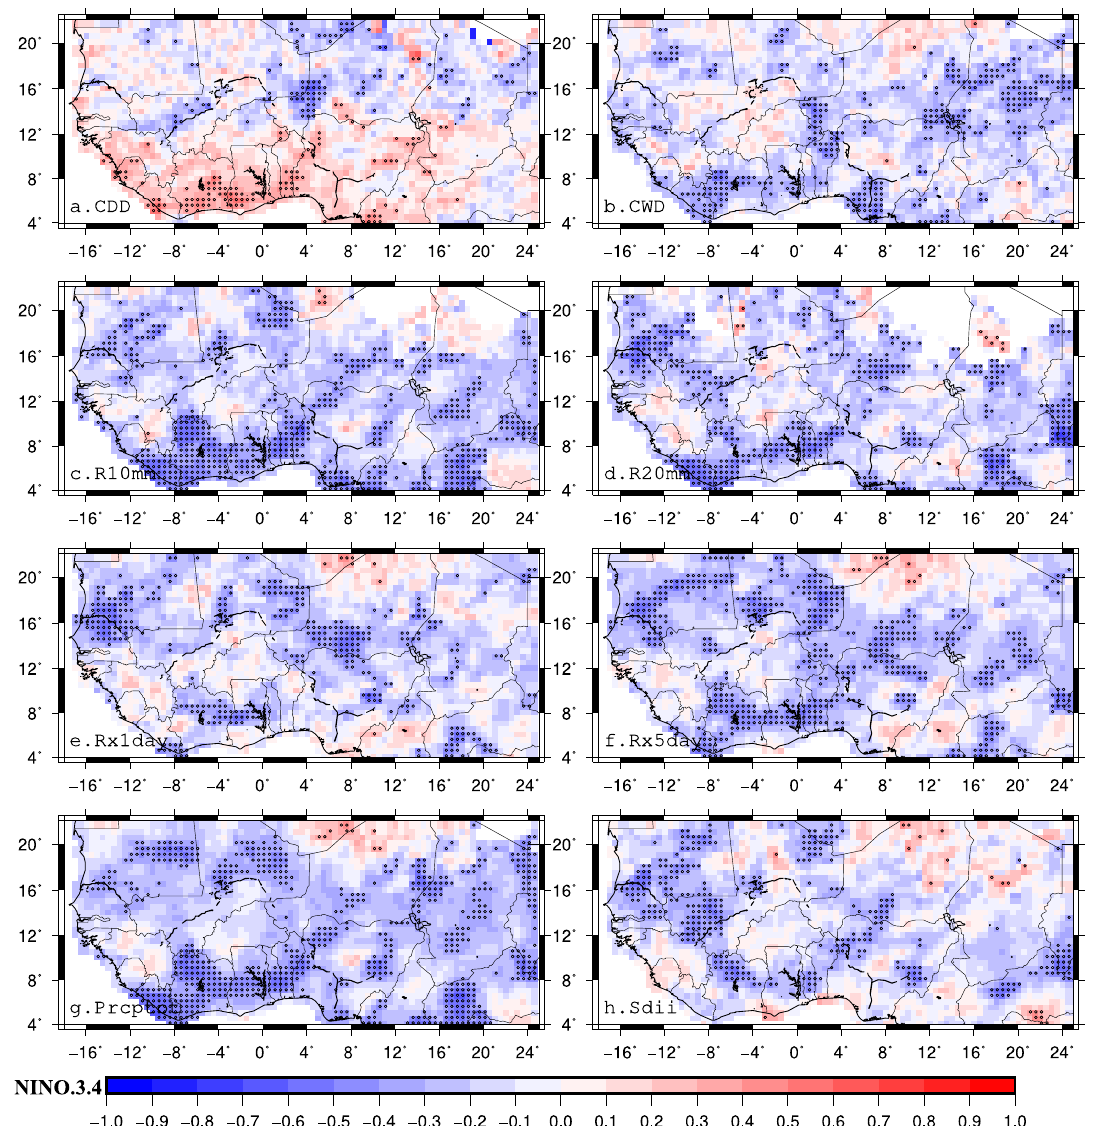
Figure 10. Correlation patterns between NINO.3.4 and extreme precipitation indices. Tipping points represent significant correlation areas using EDOF. ( a ) CDD, ( b ) CWD, ( c ) R10mm, ( d ) R20mm, ( e ) Rx1day, ( f ) Rx5day, ( g ) Prcptot and ( h ) Sdii.